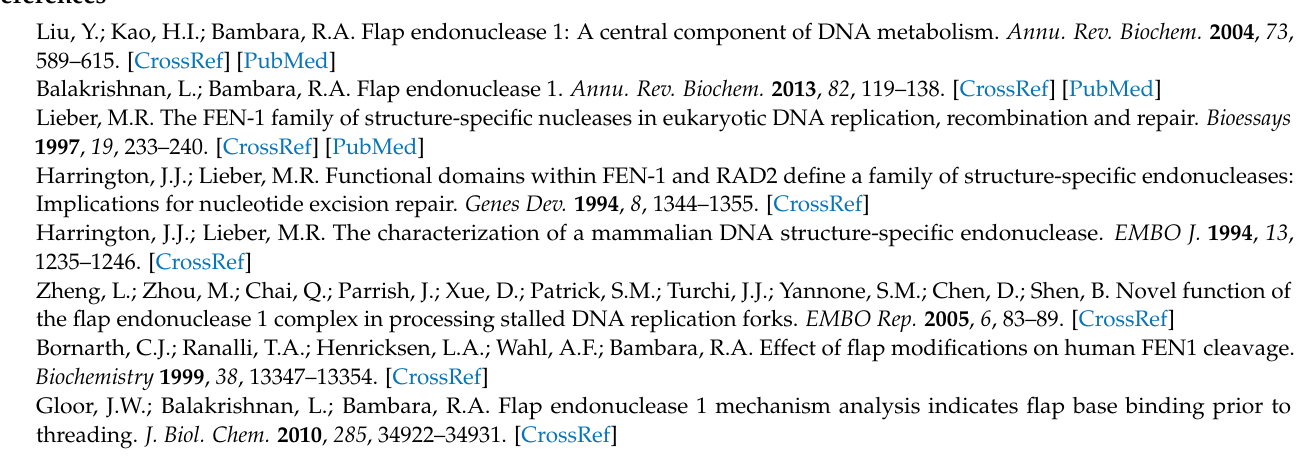
cleave RNA; Supplementary Figure S2: RNA-DNA hybrids are more abundant in AOA2 cells than normal human fibroblasts; Supplementary Figure S3: APE1 can incise an abasic site in an R-loop; Supplementary Figure S4: APE1 catalytic mutant protein does not exhibit RNA cleavage activity on R-loop intermediates; Supplementary Figure S5: FEN1 cannot make RNA cleavage on an R-loop in the absence of a DNA base